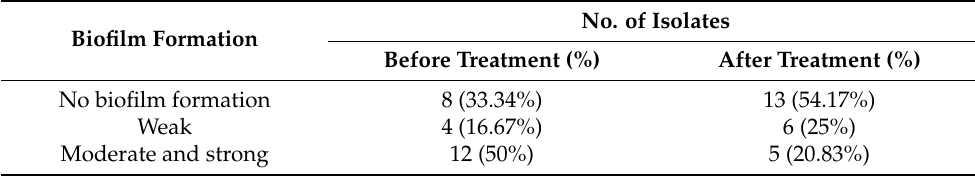
Figure 6. Bar chart showing the number of CFU/mL of S. aureus isolates in ( a ) liver and ( b ) spleen in the different experimental groups. The symbol (*) represents a significant decrease ( p < 0.05) in comparison with group I.